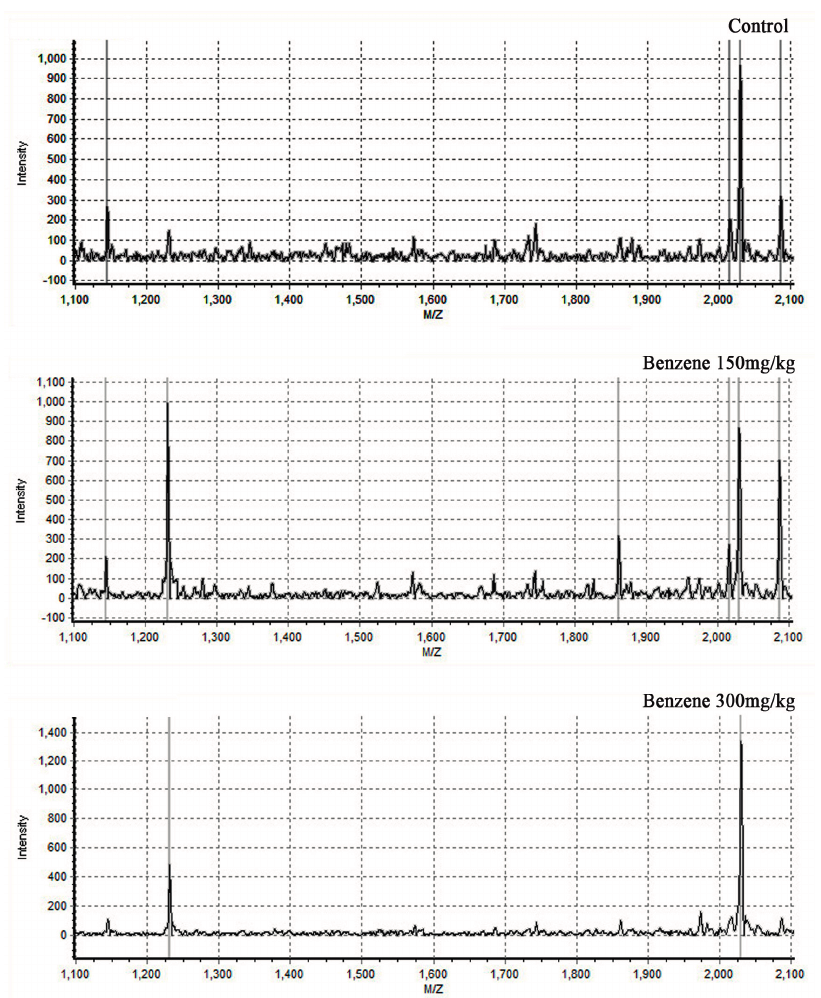
Figure 1. Sum of plasma MALDI-TOF spectra. The mass-to-charge ratio of the mass region of 1100 m/z to 2100 m/z is shown in more